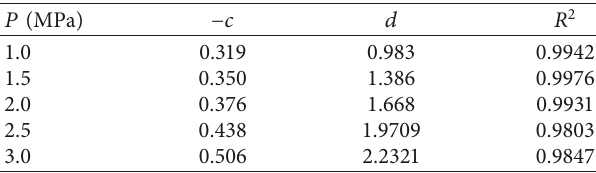
Figure 11: The variation curve of seepage velocity with the vari- ation of fractal dimension under different seepage pressure. Table 4: Characteristic parameters of seepage velocity with the variation of fractal